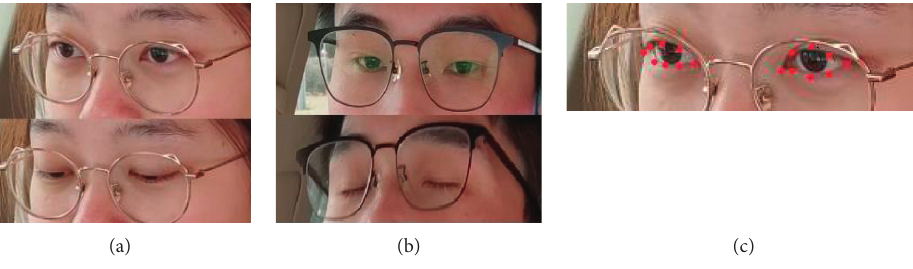
Figure 6: Comparison of eye judgment.